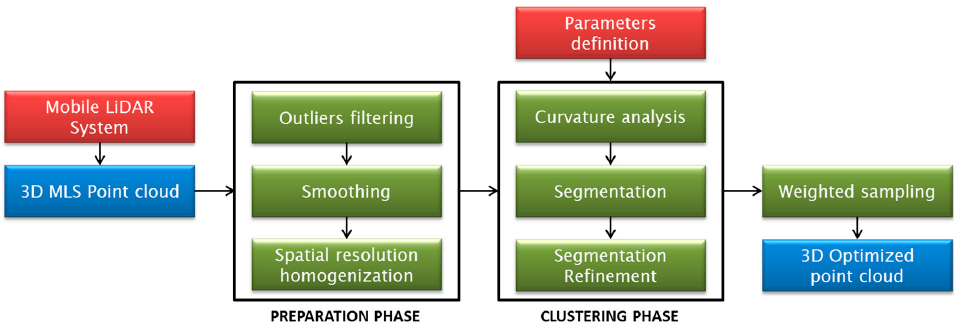
Figure 3. Pipeline for 3D point cloud optimization.